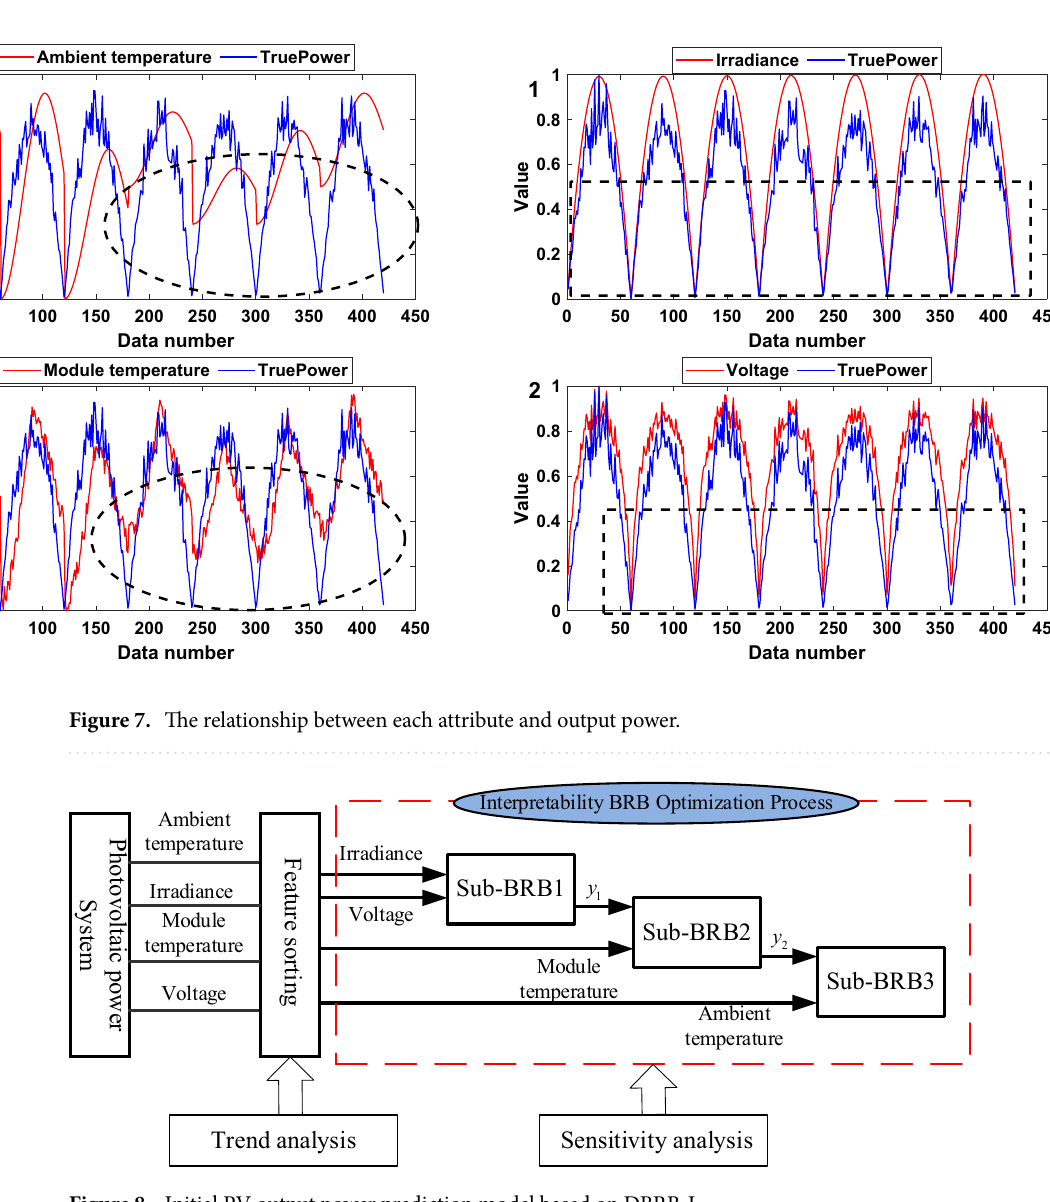
Figure 8. Initial PV output power prediction model based on DBRB-I.